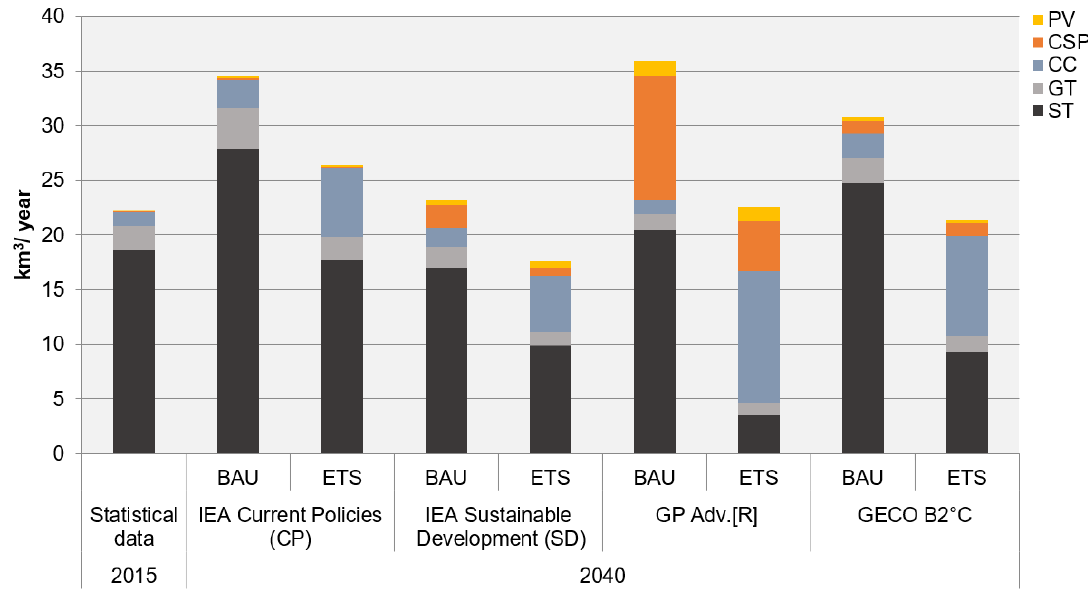
Figure 7. Water consumption for electricity generation (km 3 per year, excluding hydropower) by electricity generation technology for 2015 and the four energy scenarios in combination with changes in the power plant type and cooling technologies (BAU and ETS scenarios) in 2040. Power plant types: ST = steam turbine; GT = gas turbine; CC = combined cycle; CSP = concentrated solar power; PV = photovoltaic (values for PV correspond to the water needs for cleaning and operation); (Source: own calculation based on the data from [39–41]).